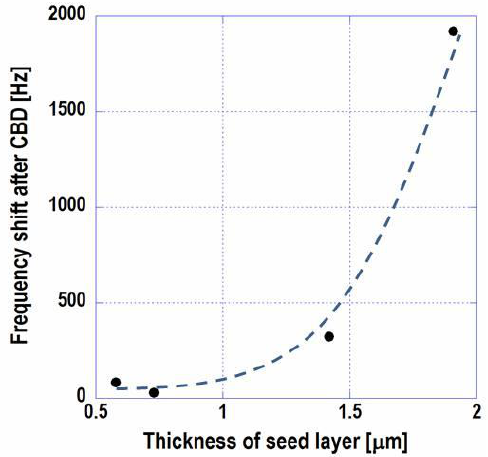
Figure 3. The magnitude of frequency shift on EtOH gas injection dependent with the thickness of the seed